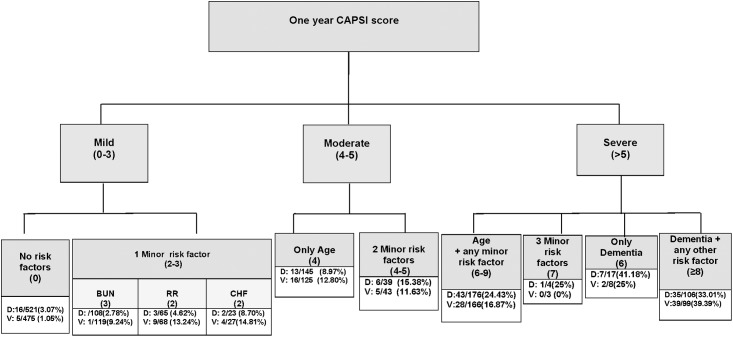
Risk-score distribution diagram according to the one-year CAPSI score risk groups.Minor risk factors: Chronic Heart Failure (CHF), Respiratory Rate (RR), Blood Urea Nitrogen (BUN). 2 minor risk factors: any pairwise combination of the minor risk factors. 3 minor risk factors: number of patients with the three minor risk factors. Age + any minor risk factor: age in combination with one, two or three minor factors. Dementia + any other risk factor: Dementia combined with other risk factor (age, one, two or three minor risk factors). D: number of deaths / number of patients at risk in the derivation sample. V: number of deaths / number of patients at risk in the validation sample.